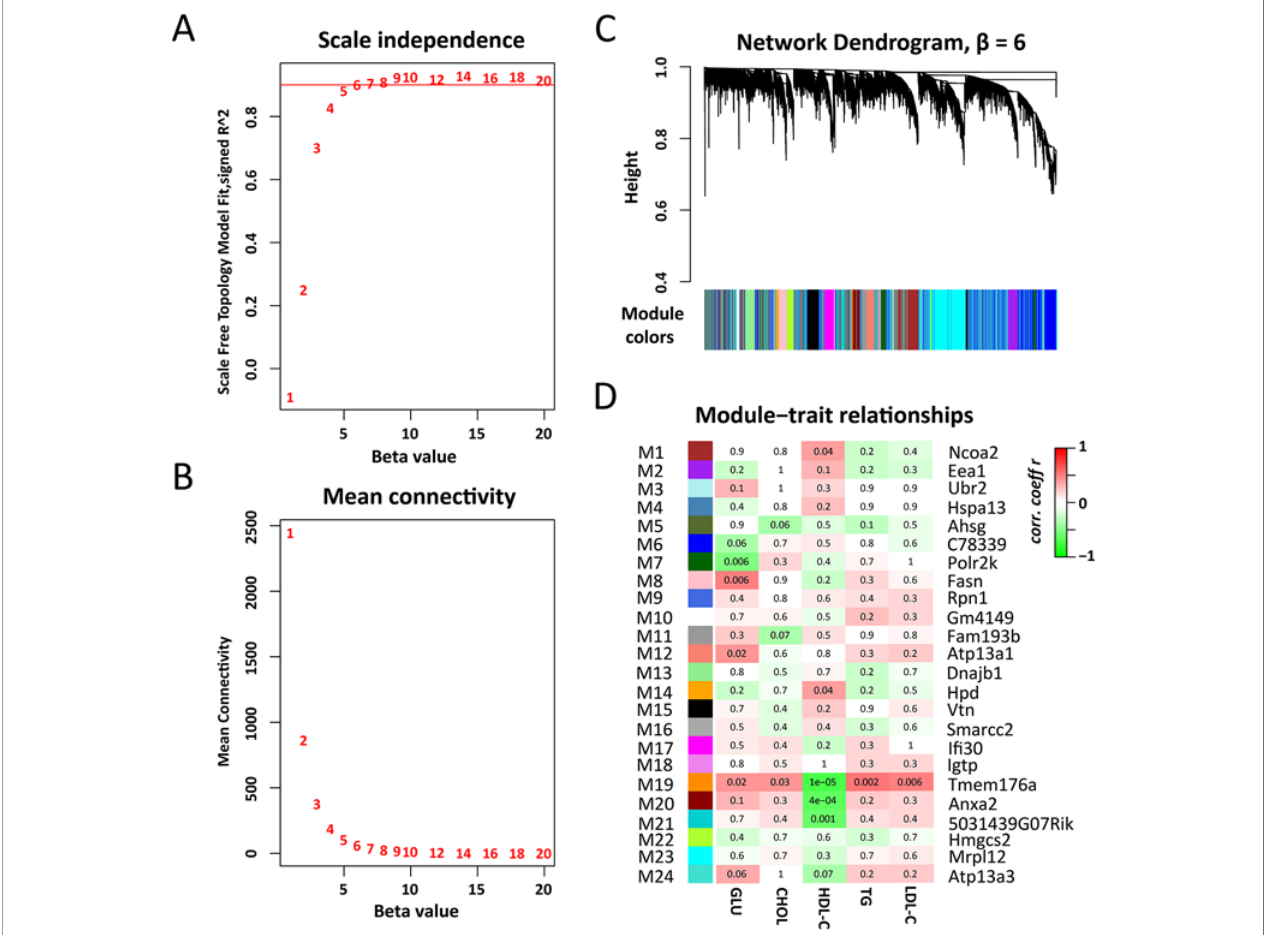
FIGURE 3 | Weighted gene co-expression network analysis of liver transcriptomes. (A) The soft thresholding index R 2 (y-axis) as a function of different thresholding power b (x-axis). (B) Mean connectivity (y-axis) as a function of the power b (x-axis). (C) Twenty four co-expression modules were identi fi ed from the liver RNA-seq dataset. WGCNA cluster dendrogram groups genes (n = 10,520) measured across C1SLs and its recipient strain B6 liver into distinct gene modules (M1 – 24) de fi ned by dendrogram branch cutting. (D) Module-trait associations. Each row corresponds to a module column to a trait. Each cell contains the corresponding correlation and p-value. The table is color-coded by correlation according to the color legend. The hub genes were indicated aside each